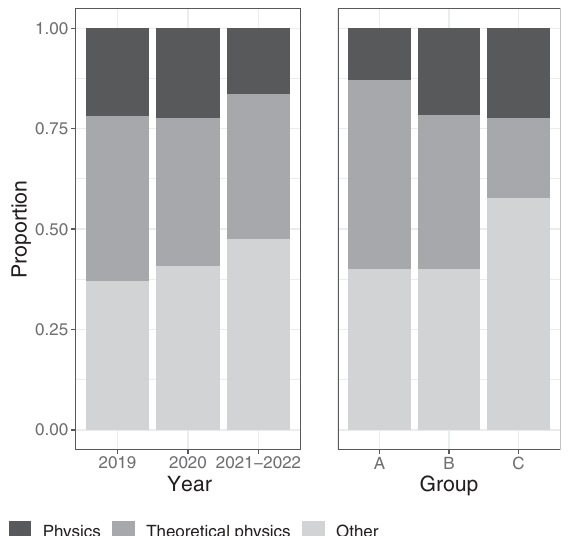
FIG. 1. Proportions of students ’ self-reported major subjects by year and LCA